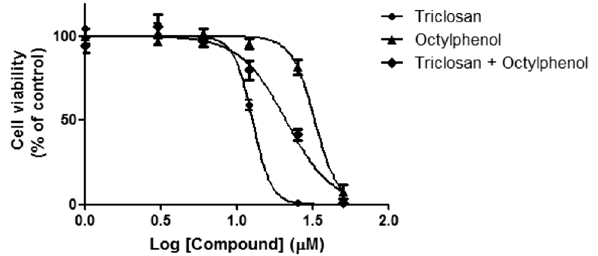
Figure 1. Concentration dependent cytotoxicity of 4-tert-octylphenol, triclosan and equimolar ratio mixture of both compounds in INS-1 cells treated for 48 h.